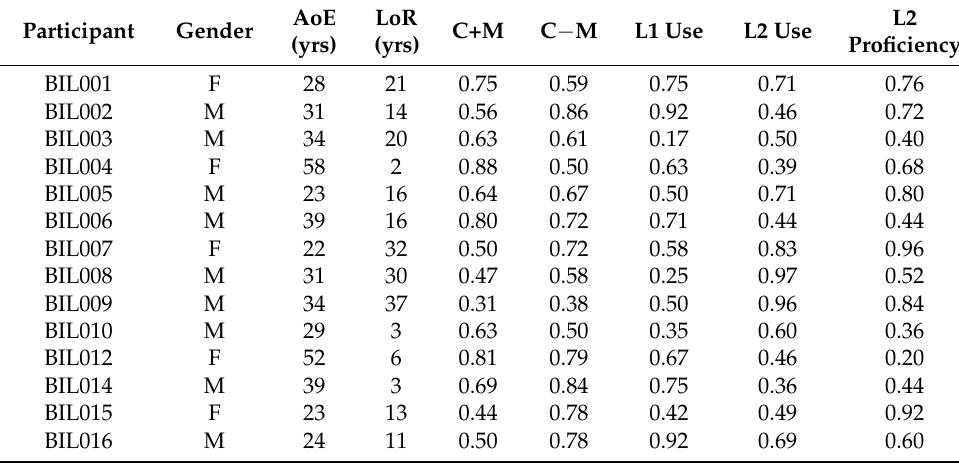
Table 1. Background details: bilingual